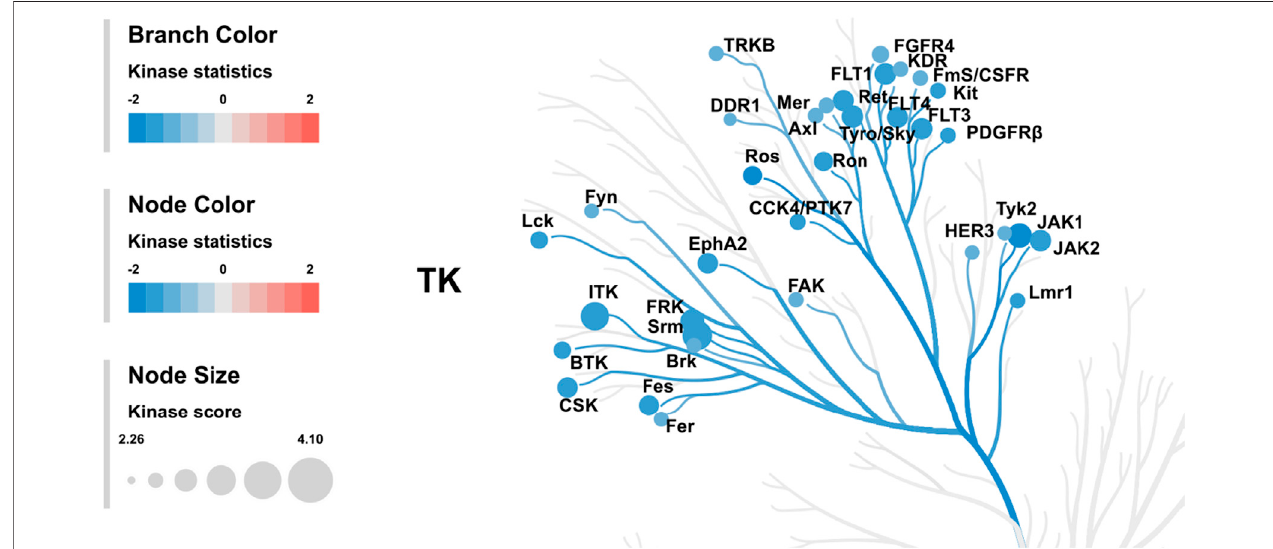
FIGURE7| Kinometree:ThetoppredictedkinasesthathavebeenchangedaftertreatmentofHL60cellswithKIM-161arerepresentedonthephylogenetictreeof thehumanproteinkinasefamily.Thesizeofthedotindicatestotalkinasescore,andthecolordenoteskinasestatistics(red:higherinon-chip – treatedlysates,blue:lower in on-chip – treated lysate). Kinase statistics cut-off ≤ − 1.2 was applied to select top